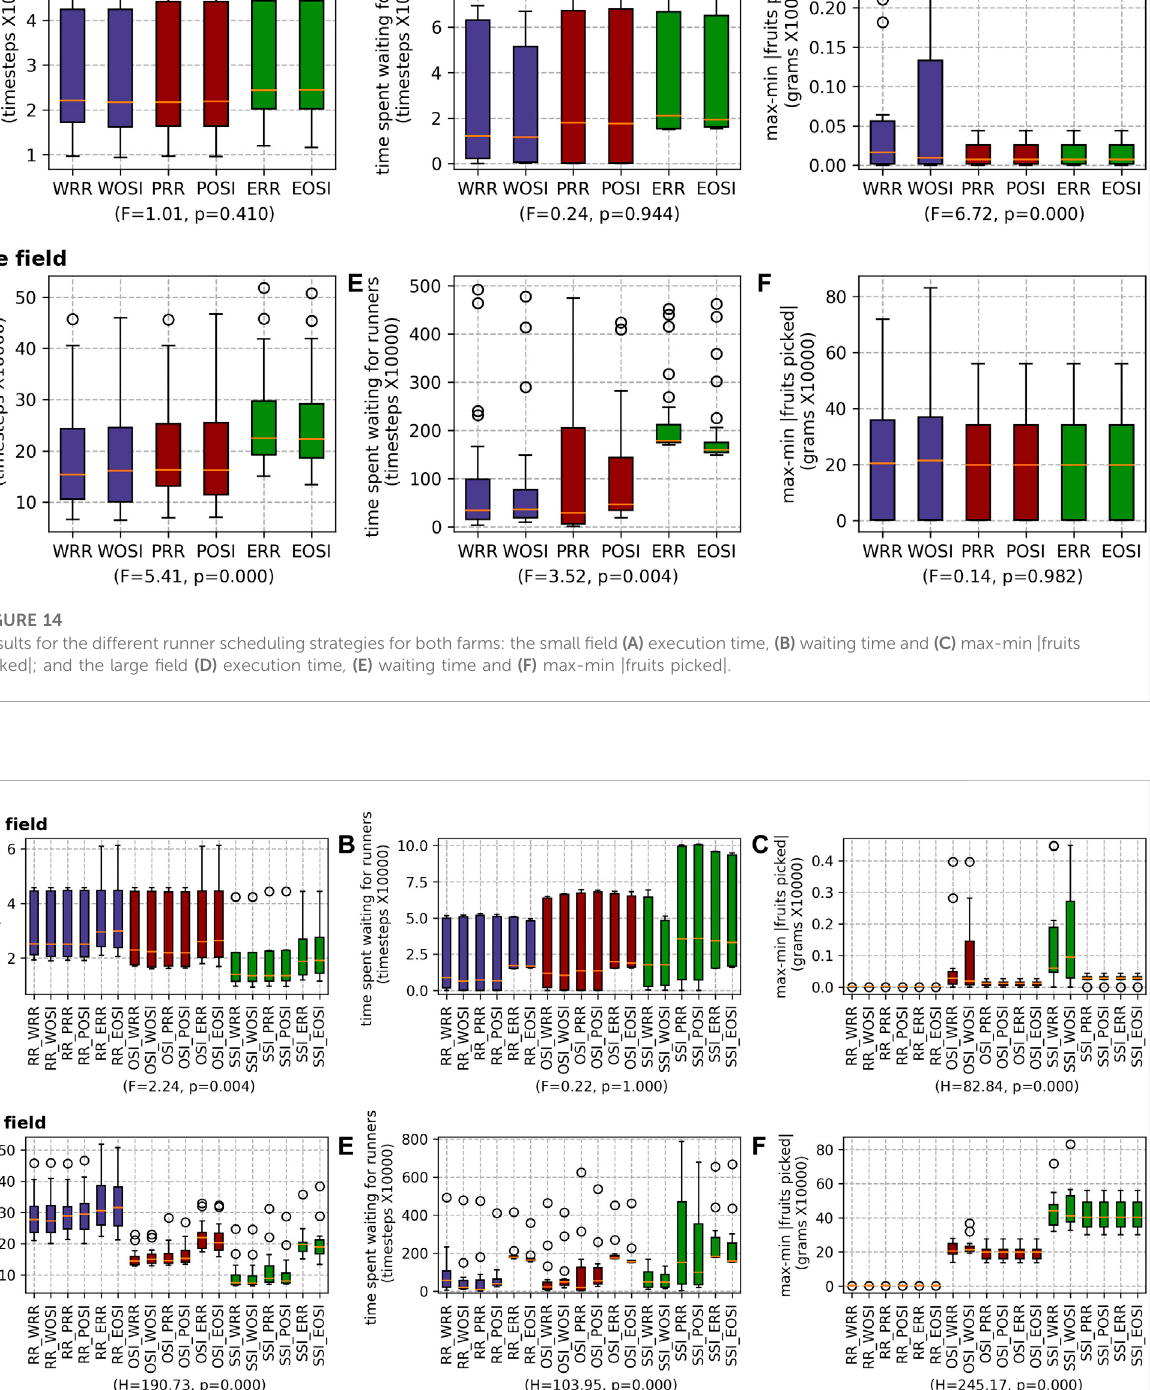
Frontiers in Robotics and